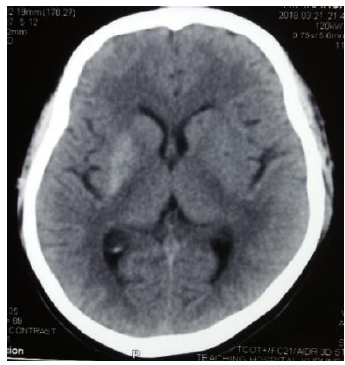
Figure 1: CT brain showing hyperdense putamen in nonketotic hyperglycemia.